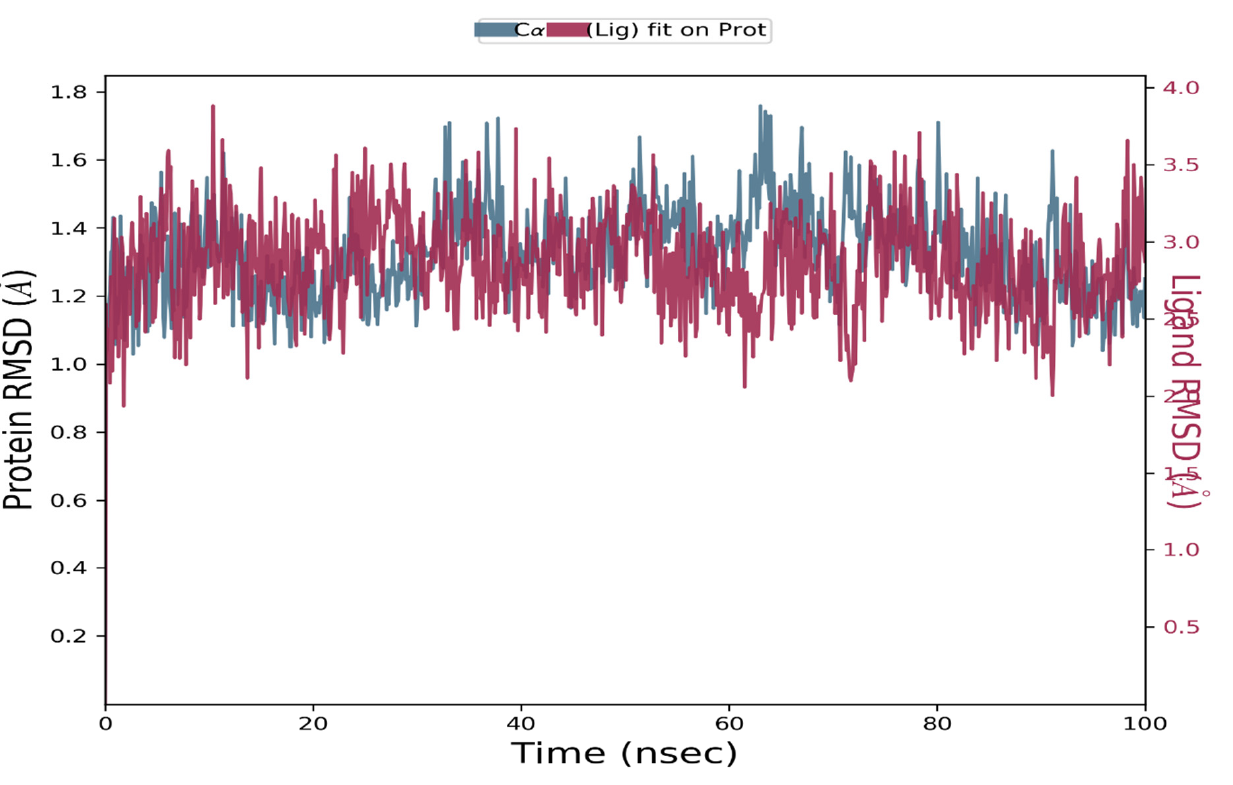
Figure 4. RMSD values of the mutated S protein and complexed guggulsterone recorded during the MD simulation of 100 ns.